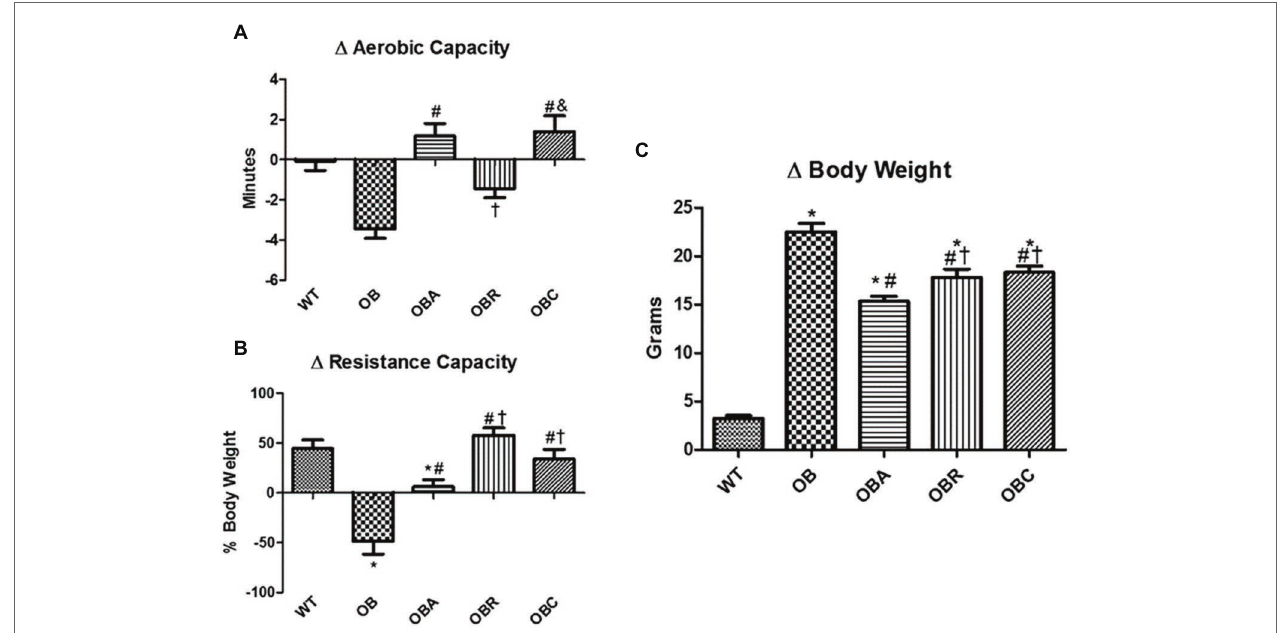
FIGURE 2 | (A) Delta of aerobic capacity; (B) delta of resistance capacity, and (C) delta of body weight. Values are mean ± SE. * p < 0.05 vs. WT; # p < 0.05 vs. OB; † p < 0.05 vs. OBA; & p < 0.05 vs.